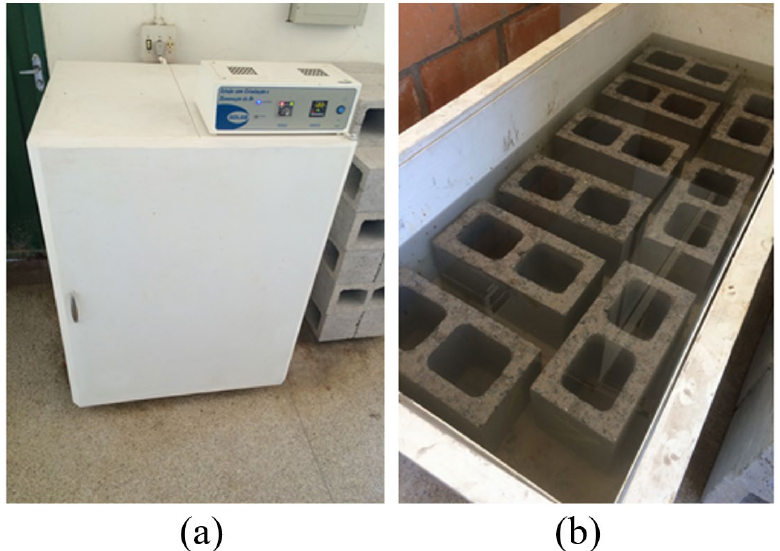
Figure 2. Exhibition environments - Oven (a) and Water tank (b). Source: Tchalekian